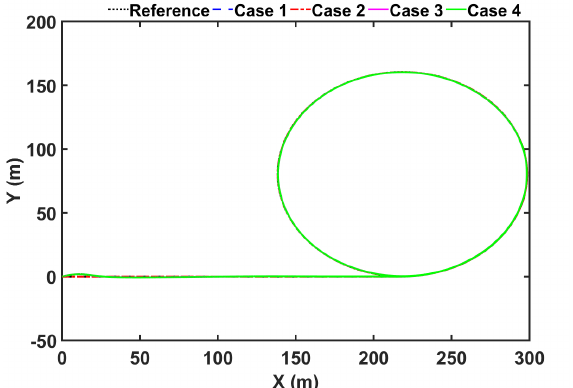
Figure 8. The trajectory tracking results with four Cases.